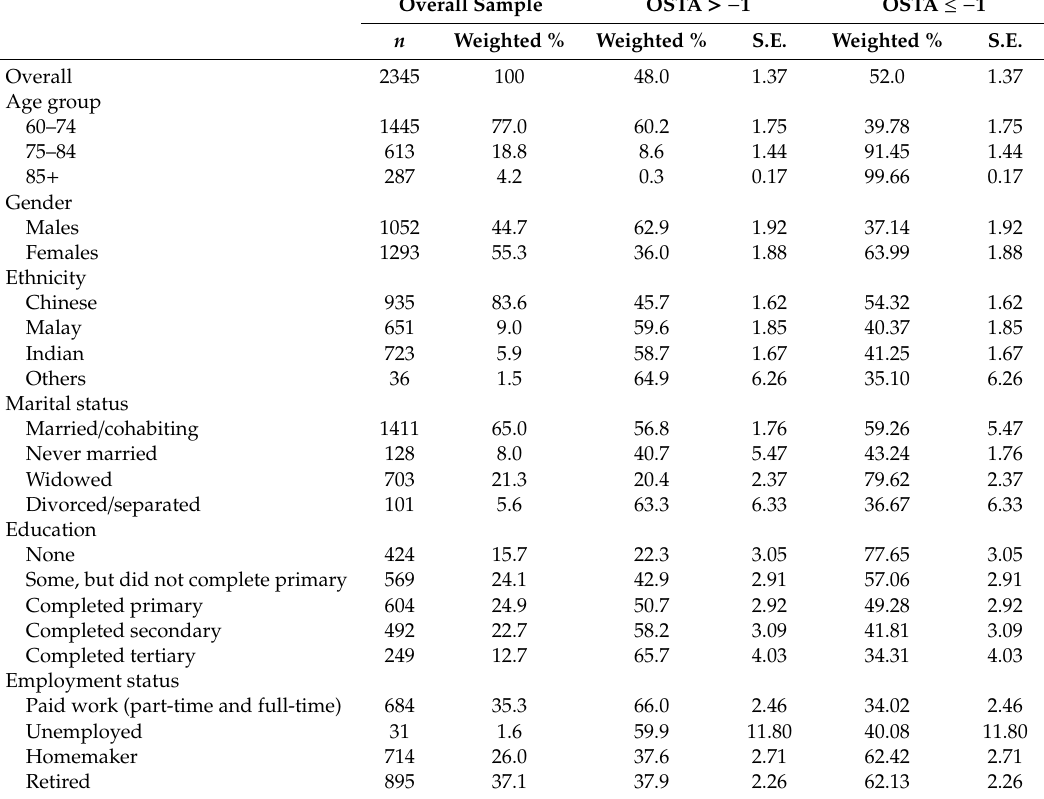
Table 1. Sociodemographic characteristics of the sample by OSTA